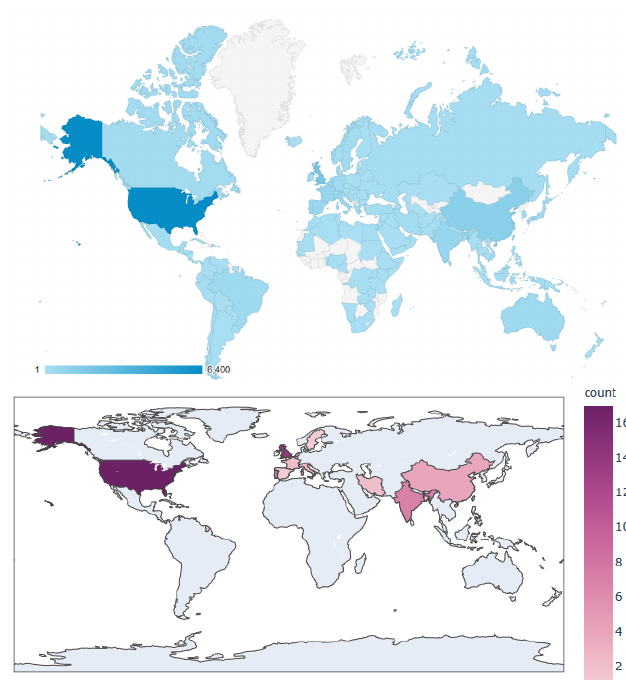
Fig. 1. Top: WEC-Sim users from Google Analytics between Nov 18, 2016 and April 14, 2021. Bottom: WEC-Sim-related publications by country of lead author’s affiliation (excluding publications from NREL and Sandia).